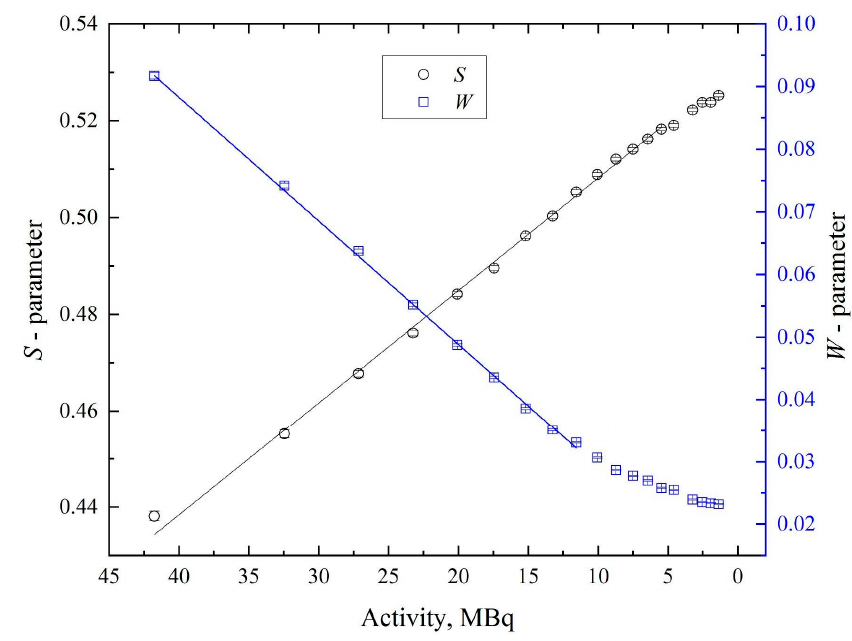
Figure 7. Dependence of S- and W- parameters of DBS on the activity of 64 Cu source.